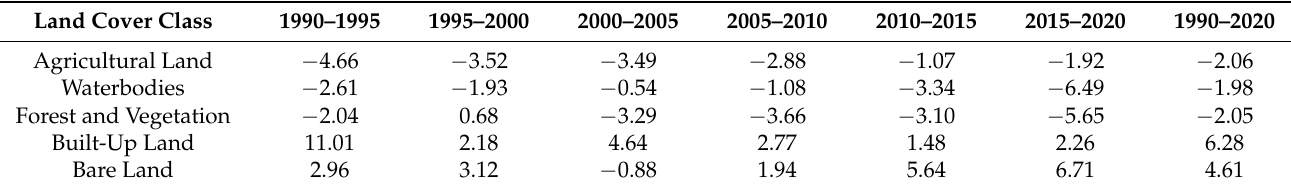
Table 5. LULC change dynamic index K (%) during 1990 to 2020.